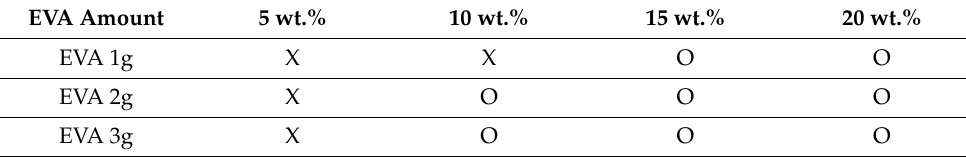
Table 1. Lamination result according to EVA amount and